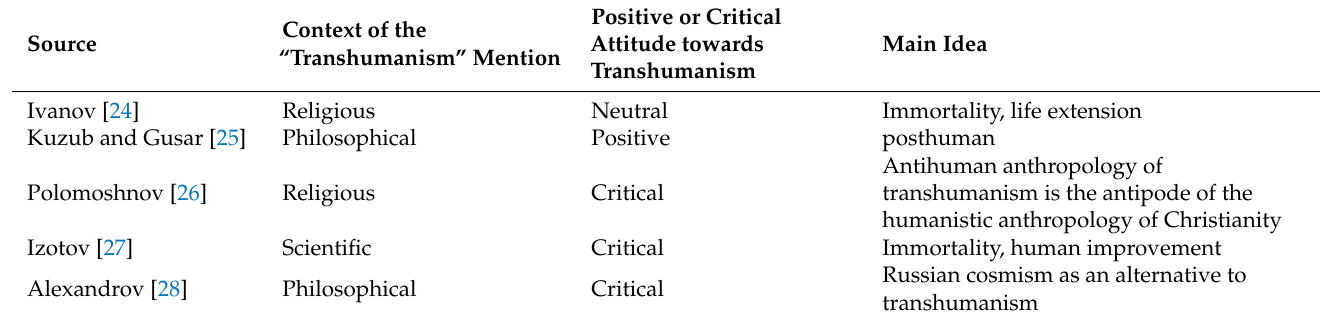
Table 1. Semantic analysis of new Russian scientific publications (2020–2021) focused on